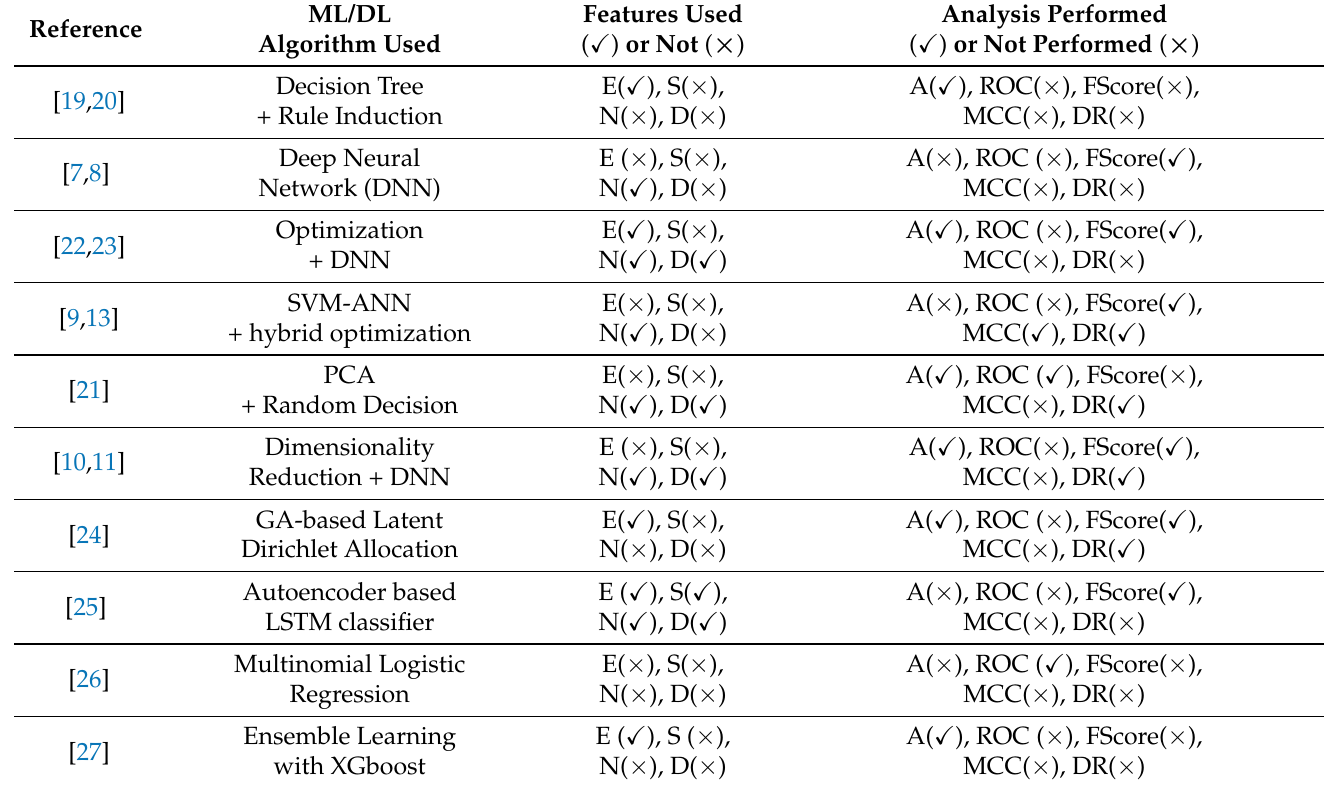
Table 1. Related Work. The letters E, S, N, and D stand for encoding, standardization, normalization, and dimensional reduction, respectively. Further, accuracy, Matthews correlation coefficient, and detection rate are denoted as A, MCC, and DR,